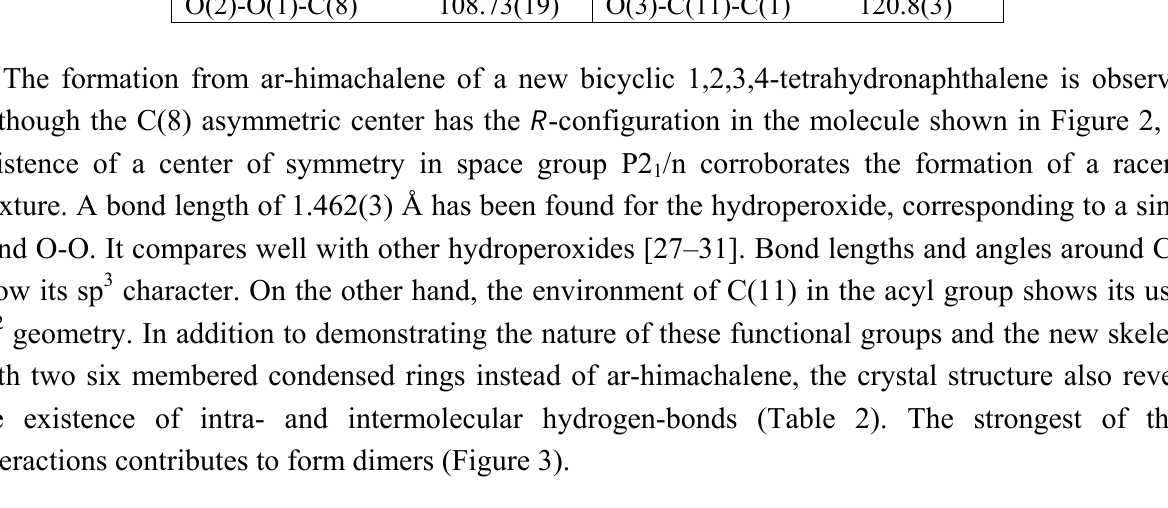
Table 2. Hydrogen-Bonds (lengths in Å, angles in °) for 3 (e.s.d.s in